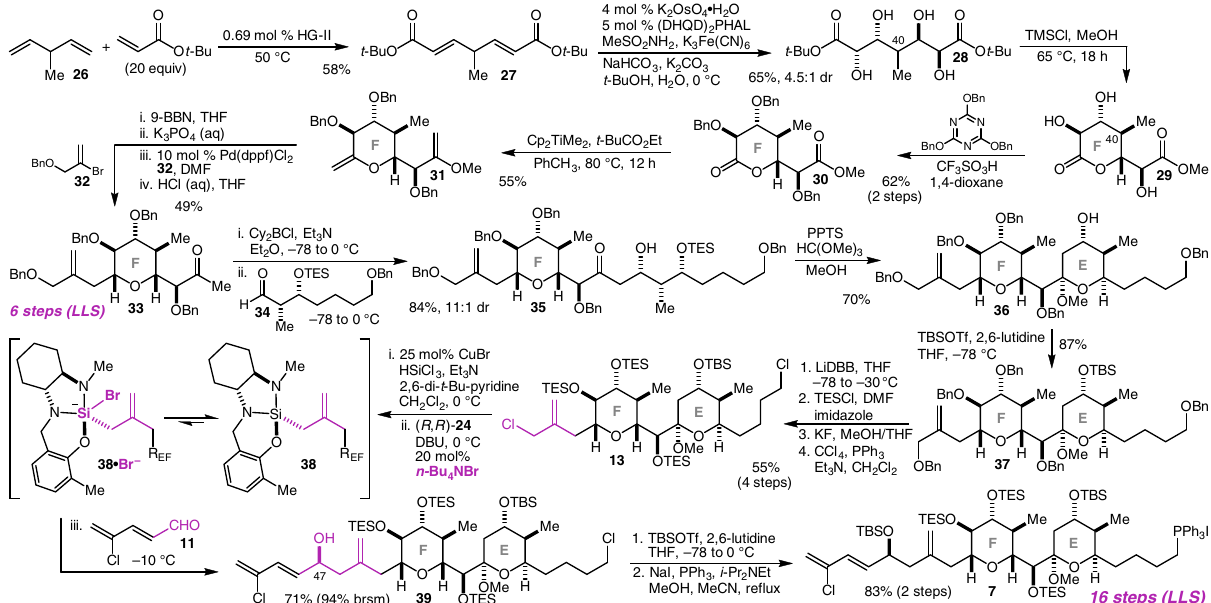
Fig. 4 A 16-step synthesis of the fully elaborated EF fragment of the spongistatins. Key steps include the double CM, double AD, and diastereoselective lactonization sequence that provides F-ring lactone 29 with fi ve stereocenters in just three scalable steps, and the direct n -Bu 4 NBr-catalyzed complex fragment coupling alkallylation reaction to incorporate the chlorodiene sidechain ( 13 + 11 to 39 ). (DHQD) 2 PHAL hydroquinidine 1,4-phthalazinediyl diether, TMSCl trimethylsilyl chloride, PPTS pyridinium para -toluenesulfonate, TBSOTf tert -butyldimethylsilyl tri fl ate, LiDBB lithium 4,4 ′ -di- tert -